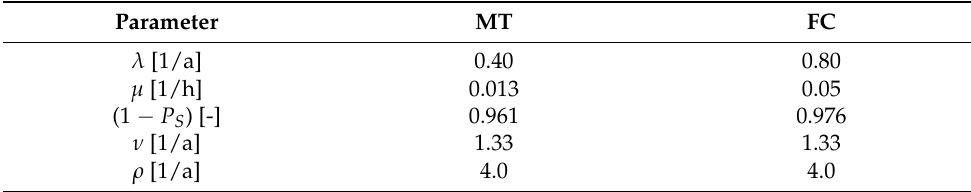
Table 3. Reliability parameters of MT and